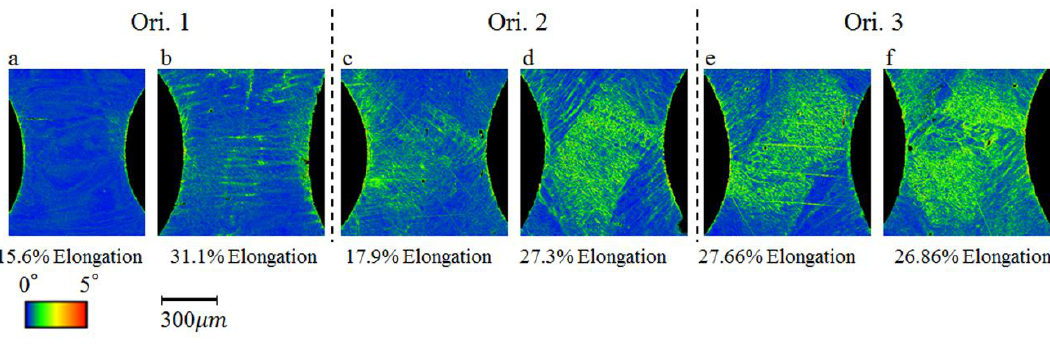
Figure 8. Kernel average misorientation maps derived from EBSD after tensile deformation of ( a ) spe. 1-1; ( b ) spe. 1-2; ( c ) spe. 2-1; ( d ) spe. 2-2; ( e ) spe. 3-1; and ( f ) spe. 3-2. Dashed lines were used to separate specimens with different initial orientations.